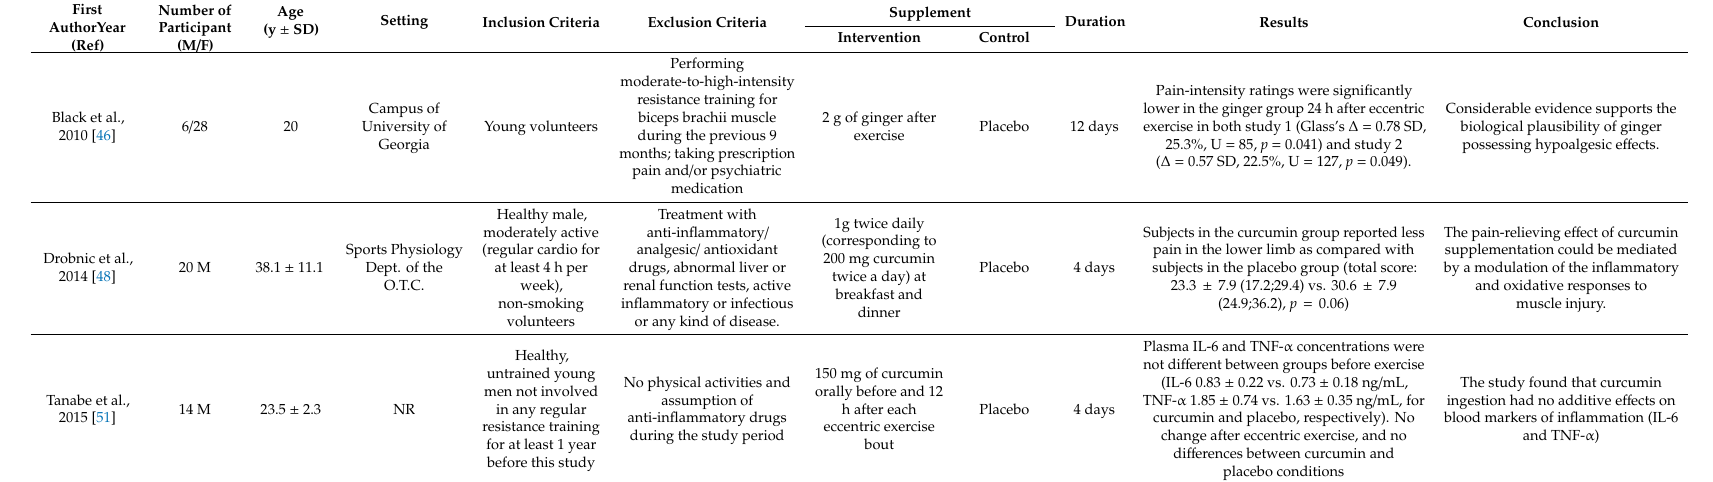
Table 3. Botanical and antioxidant